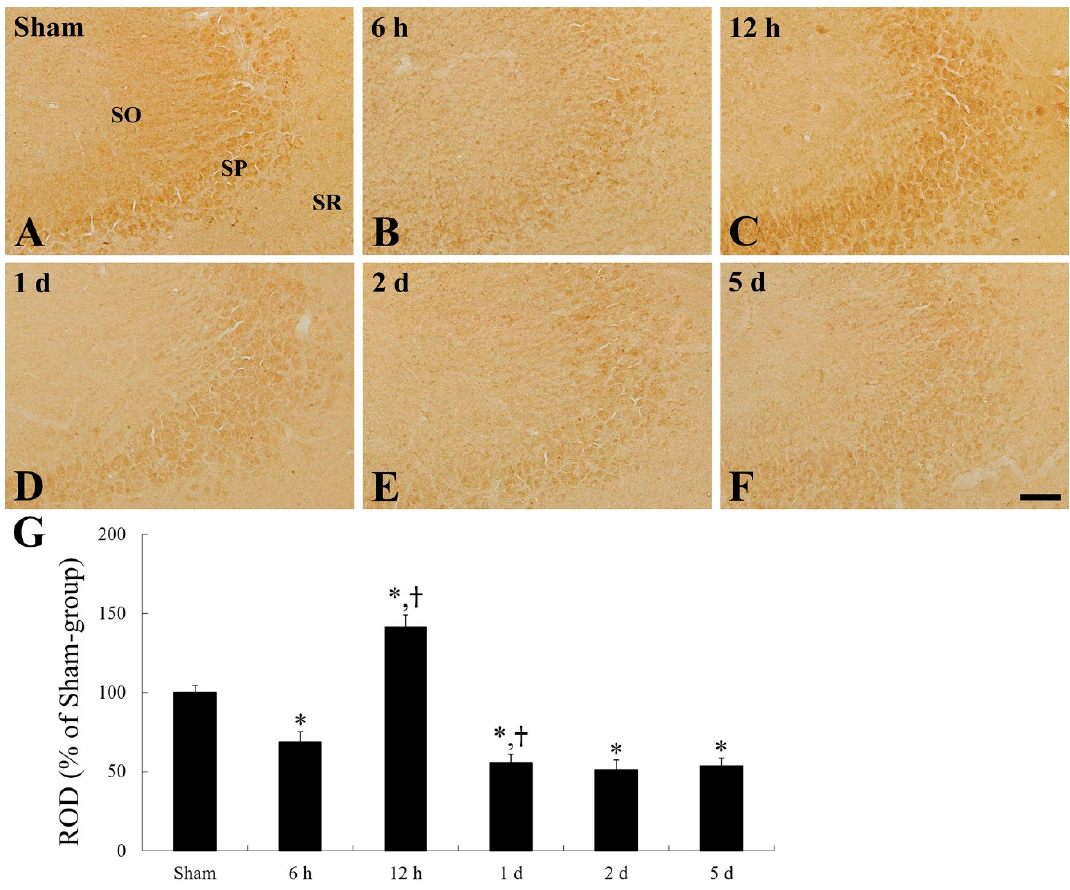
Figure 5. CD200 immunohistochemistry in the CA2/3 field of the sham group ( A ) and ischemia group ( B – F ). CD200 immunoreactivity is primarily shown in the SP. CD200 immunoreactivity in the SP is increased at 12 h after tFI; thereafter, CD200 immunoreactivity is decreased and not altered until 5 days after tFI. Scale bar = 50 µm. ( G ) ROD as % of CD200- immunoreactive structures in the hippocampal CA3 field ( n = 7 at each time; * p < 0.05, significantly different from sham group; † p < 0.05, significantly different from pre-time point group). Bars in “G” indicate the means ± SEM.